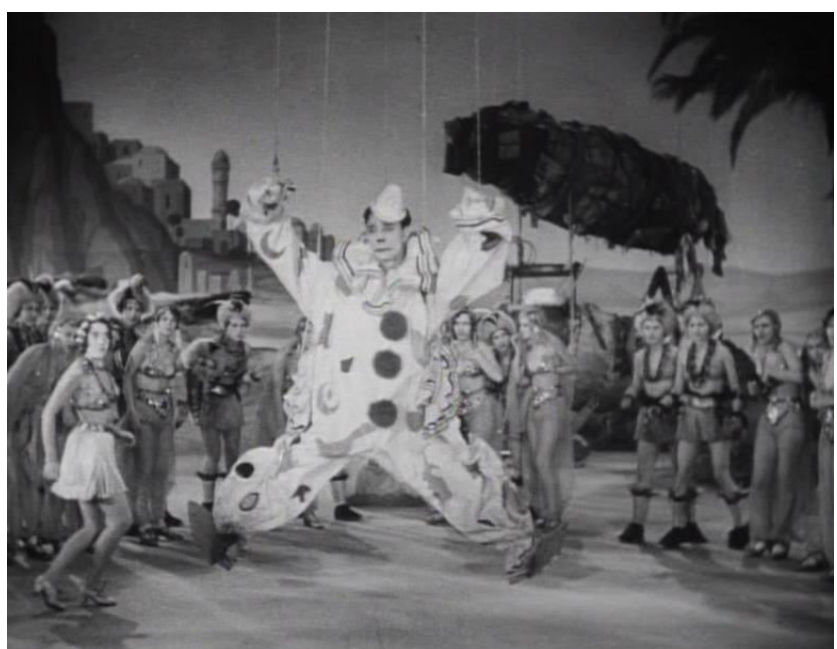
Figure 11. In the desert setting of “The Free and Easy” musical number, Elmer, as a magic clown, inexplicably emerges as a jack-in-the-box, transformed into a life-size